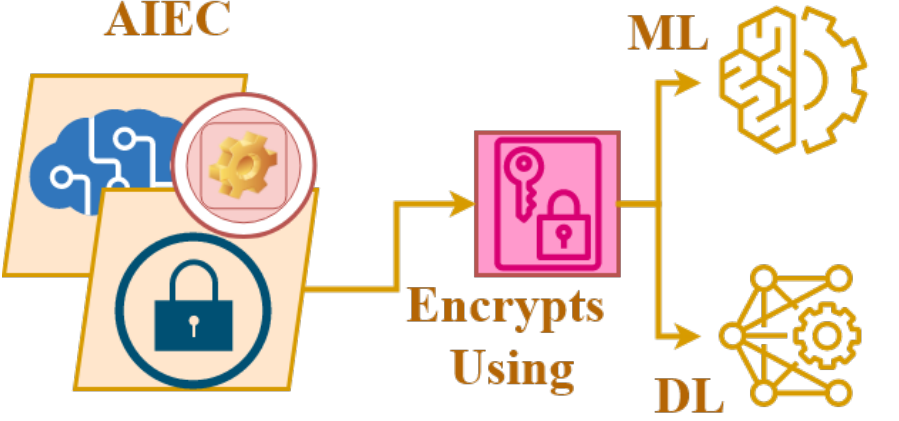
Figure 7. AIRC: Adopts ML and DL for